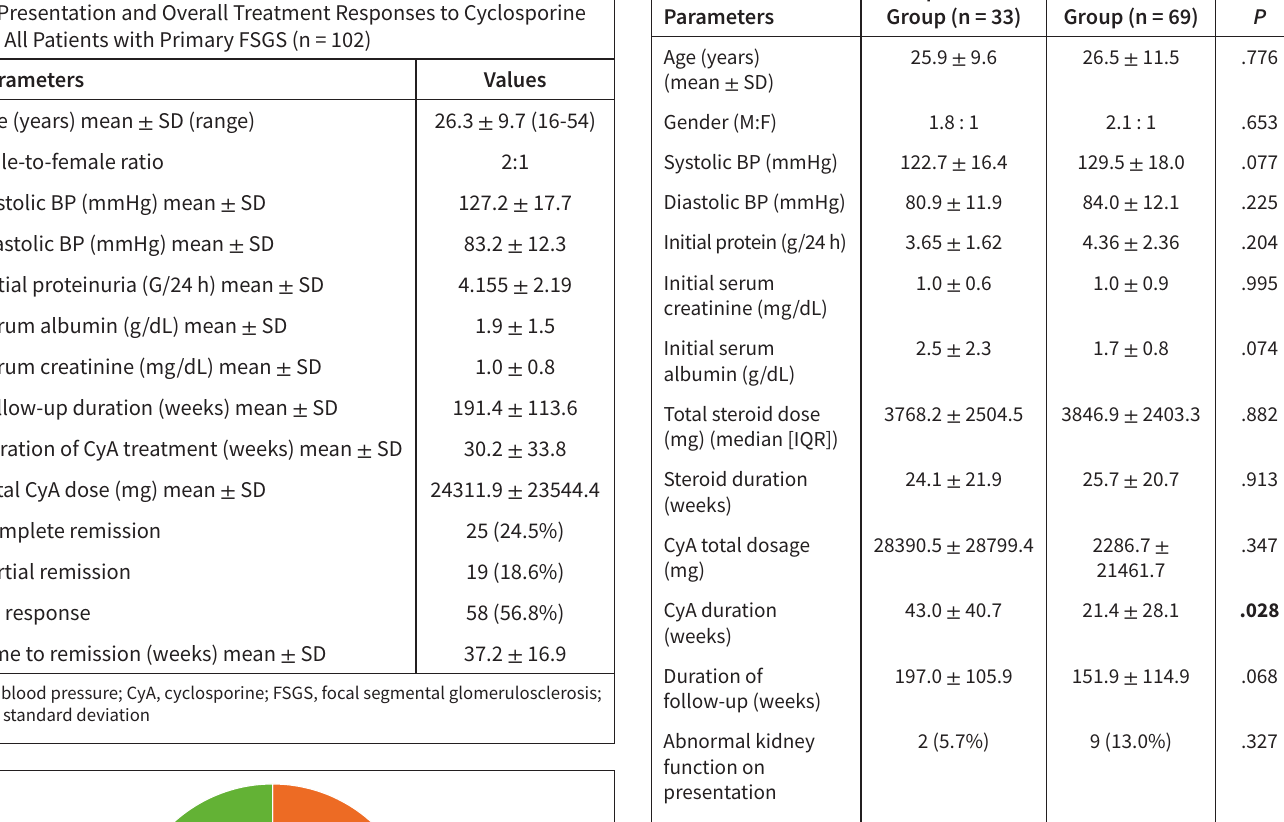
Table 1. The Main Demographic, Clinical, and Laboratory Findings